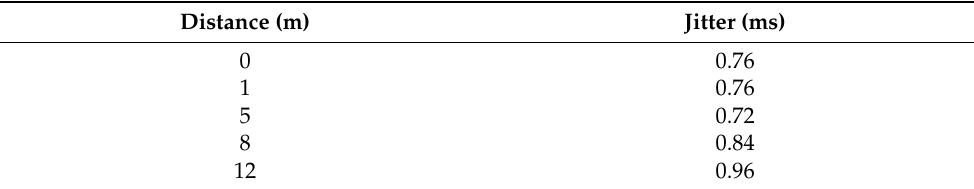
Table 4. Reception jitter at three different Smart Measuring Nodes at different